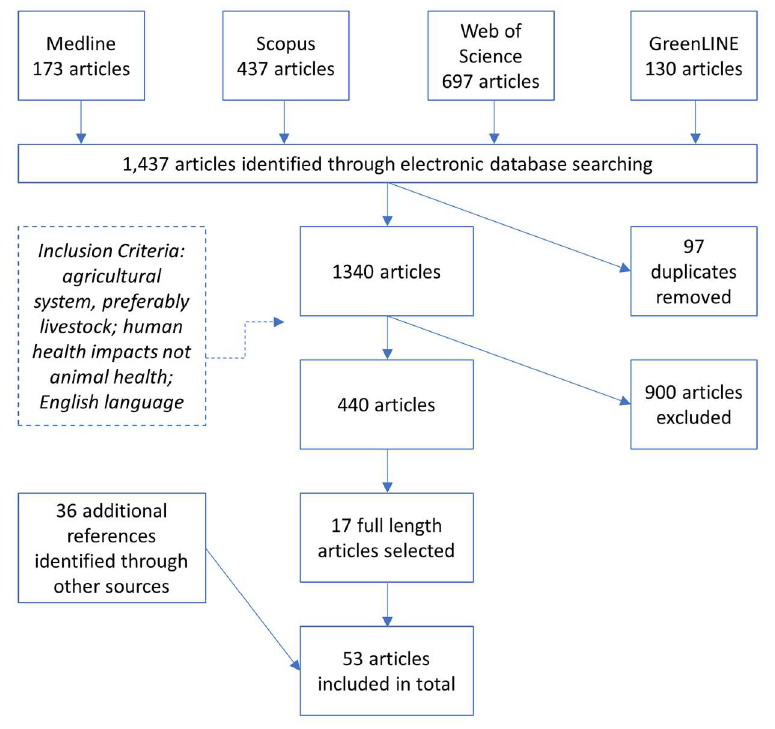
Figure 1. The search strategy and article selection flow diagram.